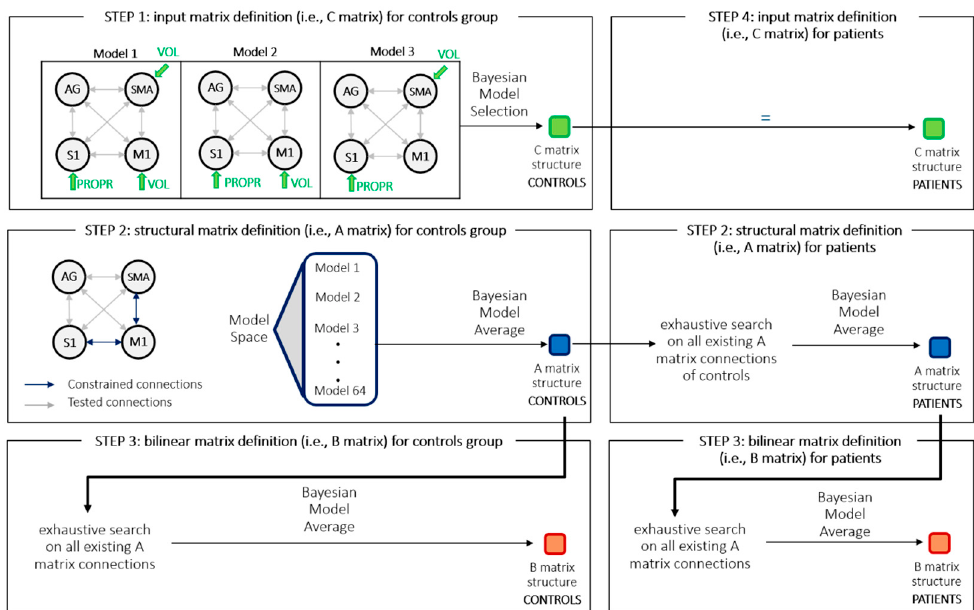
Figure 1. Representation of steps involved in the procedure for model structure identification. STEP 1: input